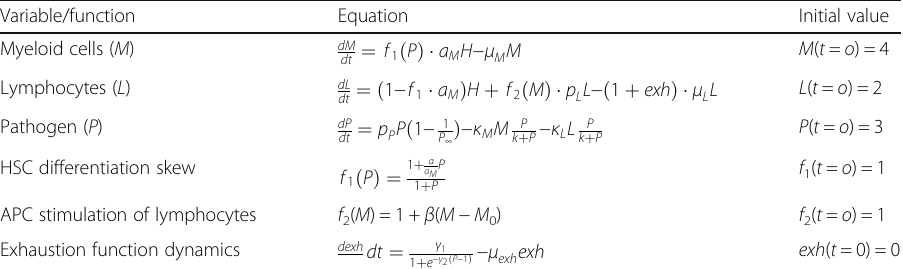
Table 2 Equations for model V2, which differs from model V1 in having an additional assumption of lymphocyte exhaustion process. Parameter definitions and values: HSC population, H = 0.5; homeostasis probability of HSC differentiation into a myeloid cell, a M = 0.2; myeloid death rate, μ p μ M = 0.025; lymphocyte proliferation rate, L =0.2; lymphocyte death rate, L = 0. 4; pathogen proliferation rate, p P values vary. Pathogen killing rate by myeloid cells, κ M = 0.6; pathogen killing rate by lymphocytes, κ L = 1; HSC skew regulator, α = 0.8; rate of APC stimulation of lymphocytes, β = 0.2. Exhaustion effect increases in presence of pathogen. Rate of increase in exhaustion effect, γ 1 = 0.005; degree to which pathogen affects onset of exhaustion, γ 2 = 100; rate of dissipation of exhaustion effect, μ exh = 0.002. See Additional file 1 for a concise summary and explanation of the equations and parameters for all models presented in this article Variable/function